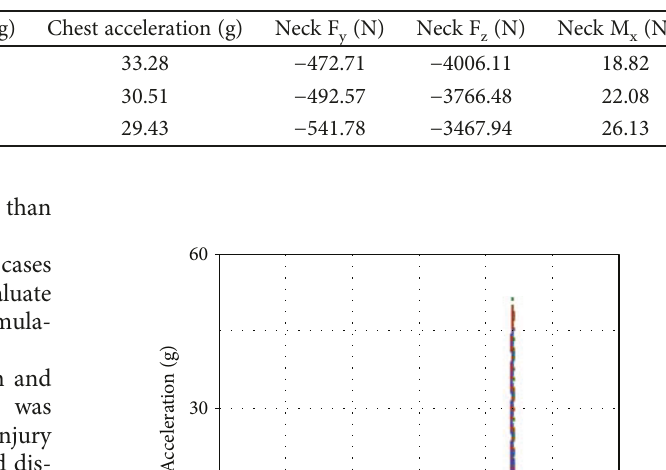
Table 2: Occupant injuries with di ff erent airbag in fl ators.